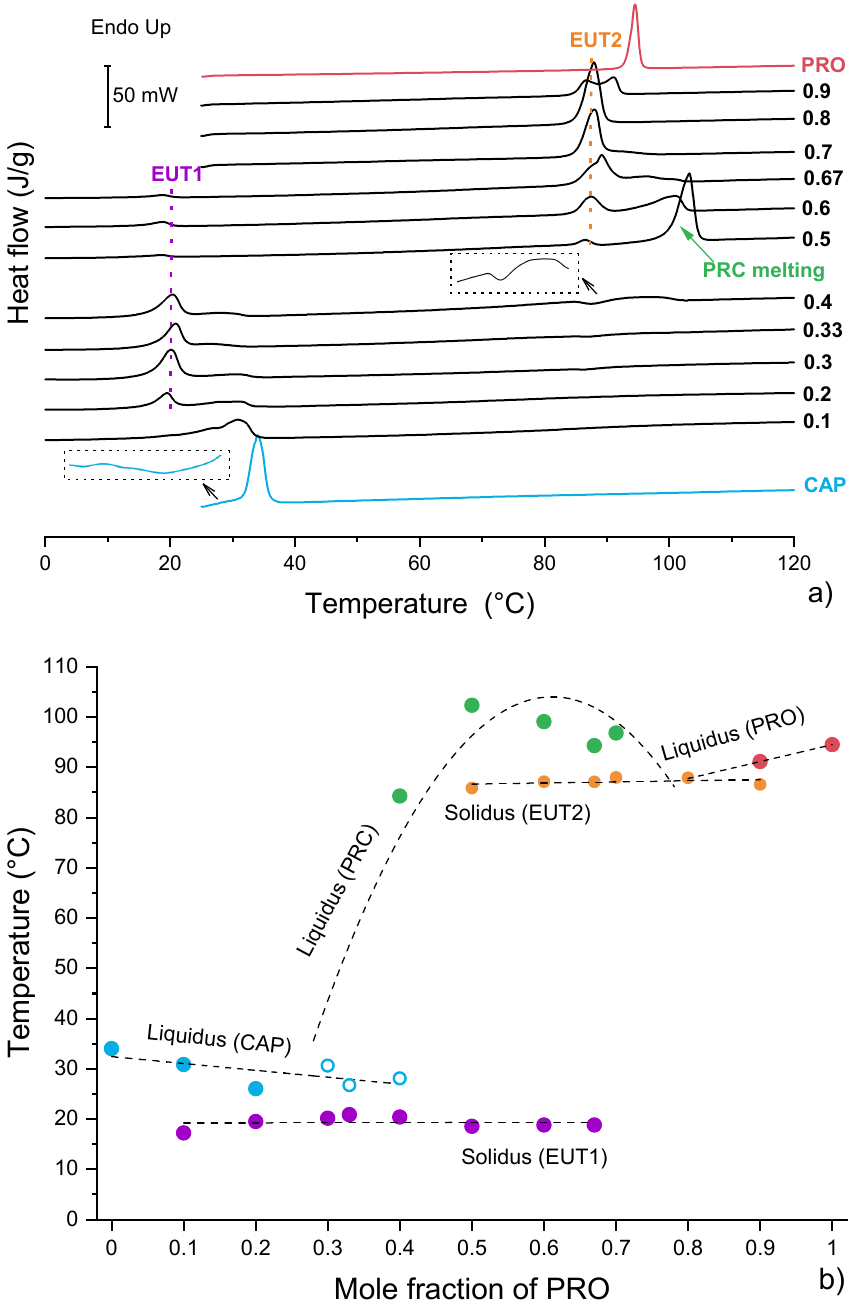
Figure 5. Thermal analysis of binary physical mixtures of PRO and CAP: ( a ) DSC traces of PRO − CAP physical mixture for first heating cycle. The labels represent mol fraction of PRO. ( b ) Tempera- ture/composition phase diagram for the PRO − CAP system. Open symbols indicate uncertainty in identifying the phase. The broken lines are used as a guide for the eye.